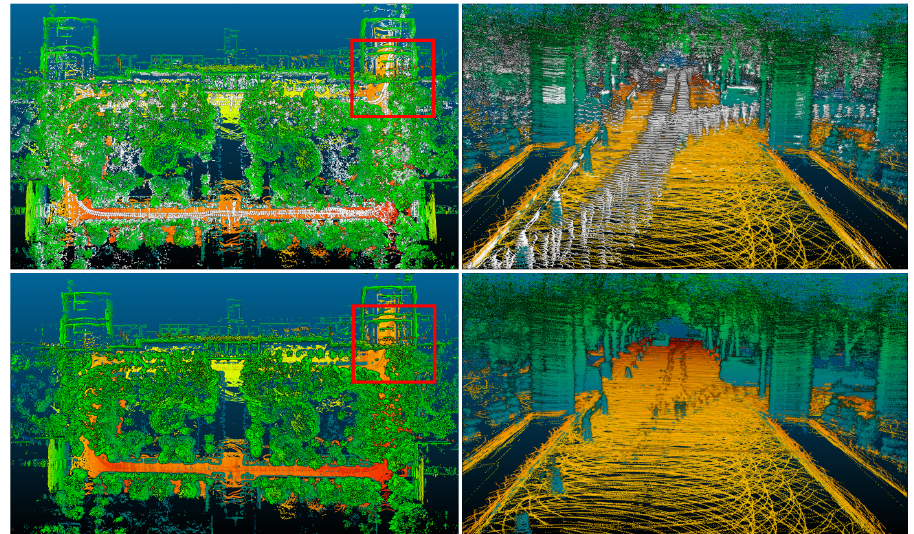
Figure 10. Outdoor mapping result of building with white points corresponding to the moving objects. The first row is the result of LeGO-LOAM while the second row is from our system.